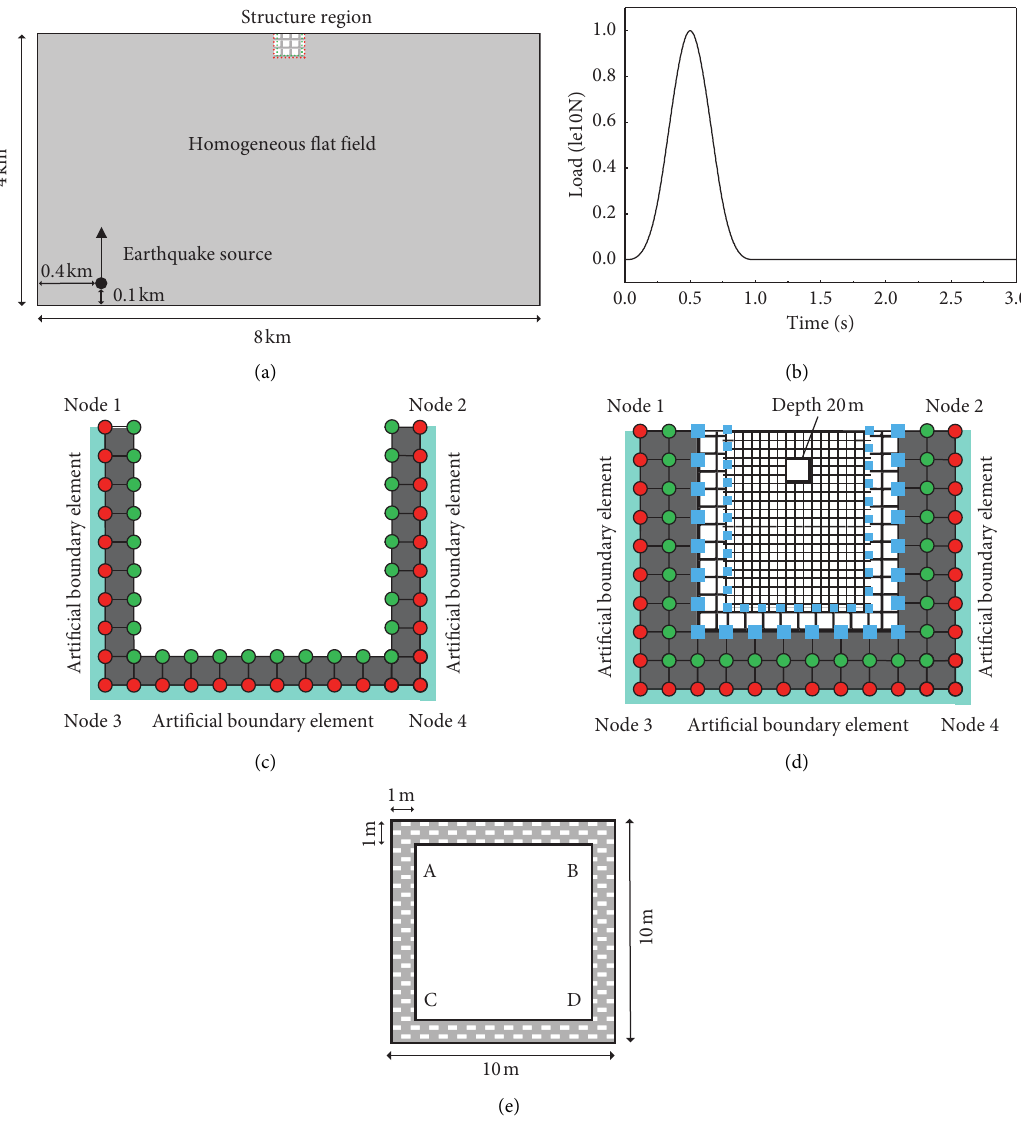
Figure 11: Model of Example 4.1.1 (burial depth is 20m): (a) the large-scale source-site model, (b) load history, (c) artificial boundary substructure model, (d) SSI model, and (e) underground structure